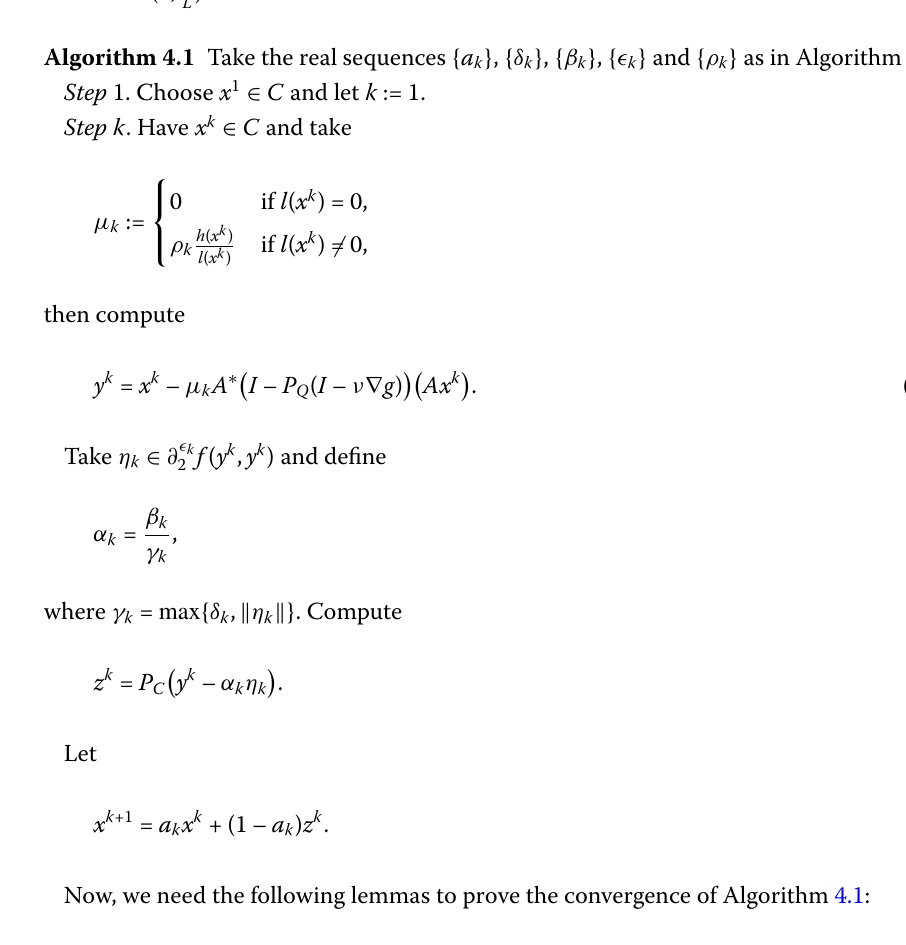
Algorithm 4.1 Take the real sequences { a k } , { δ k } , { β k } , { (cid:4) k } and { ρ k } as in Algorithm